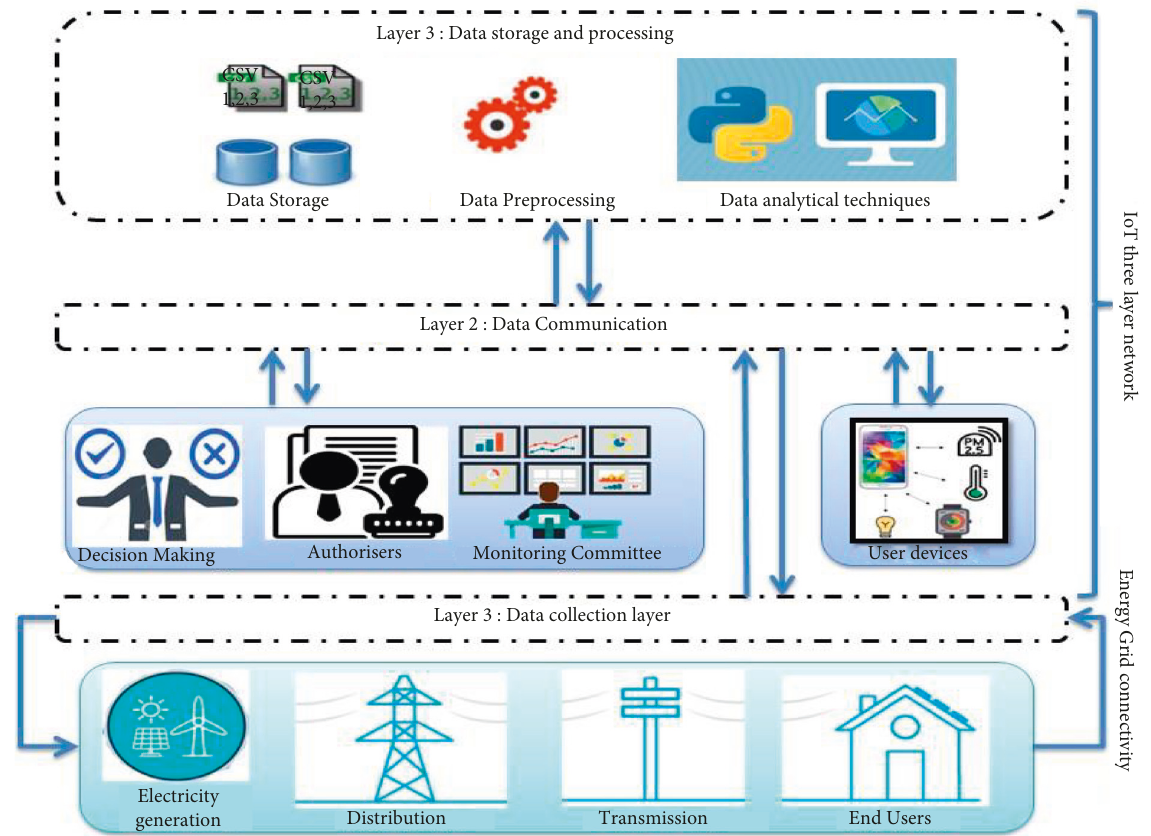
Figure 3: IoT-integrated smart energy grid three-layered network. This concept is partially adapted from Babar et al.